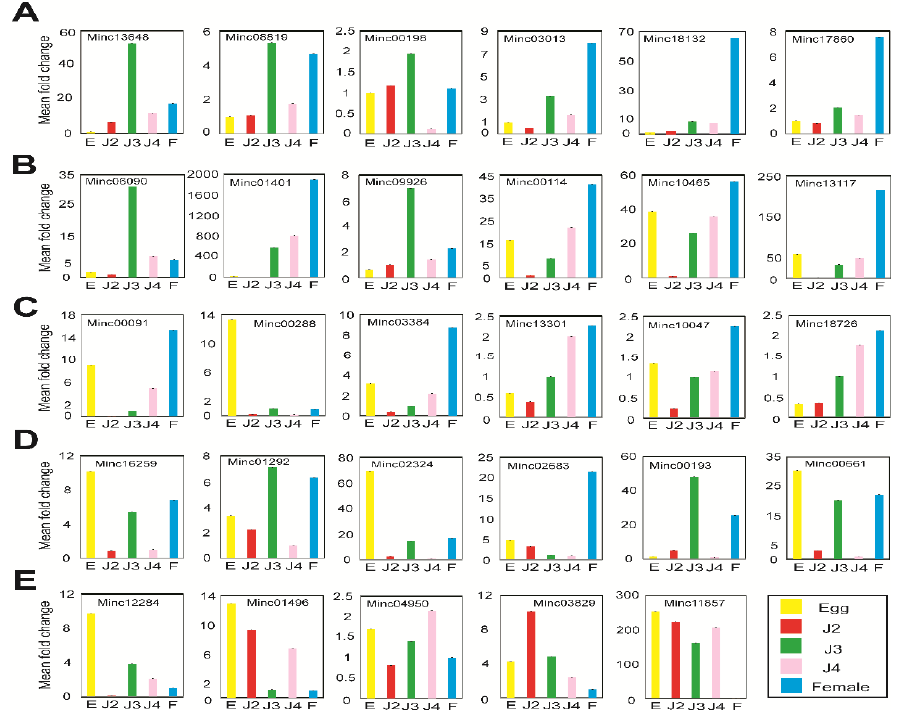
Figure 9. Validation of sequencing and real-time expression of stage-specific miRNAs targeting mRNAs. ( A ) egg stage; ( B ) J2 stage; ( C ) J3 stage; ( D ) J4 stage; ( E ) female stage. Bar color indicates developmental stage: yellow, egg; red, J2; green, J3; pink, J4; and blue, female. E: Egg; F: